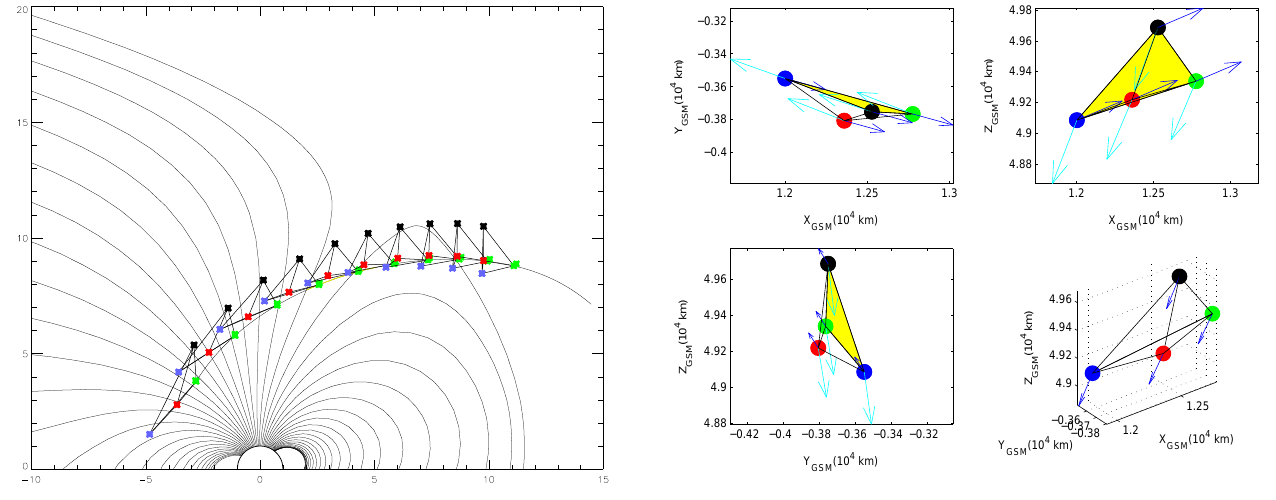
Fig. 2. Cluster trajectory between 02:00–11:00UT with magnetic field lines from the Tsyganenko (1989) model at 05:00UT shown for reference. For clarity, the distances between the spacecraft are a factor of 20 larger than in reality.